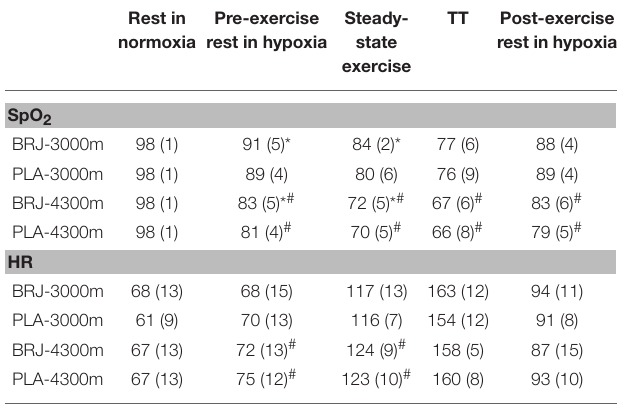
TABLE 1 | Group mean (SD) peripheral oxygen saturation (SpO 2 ) and heart rate (HR) following BRJ and PLA supplementation at 3,000 and 4,300m simulated